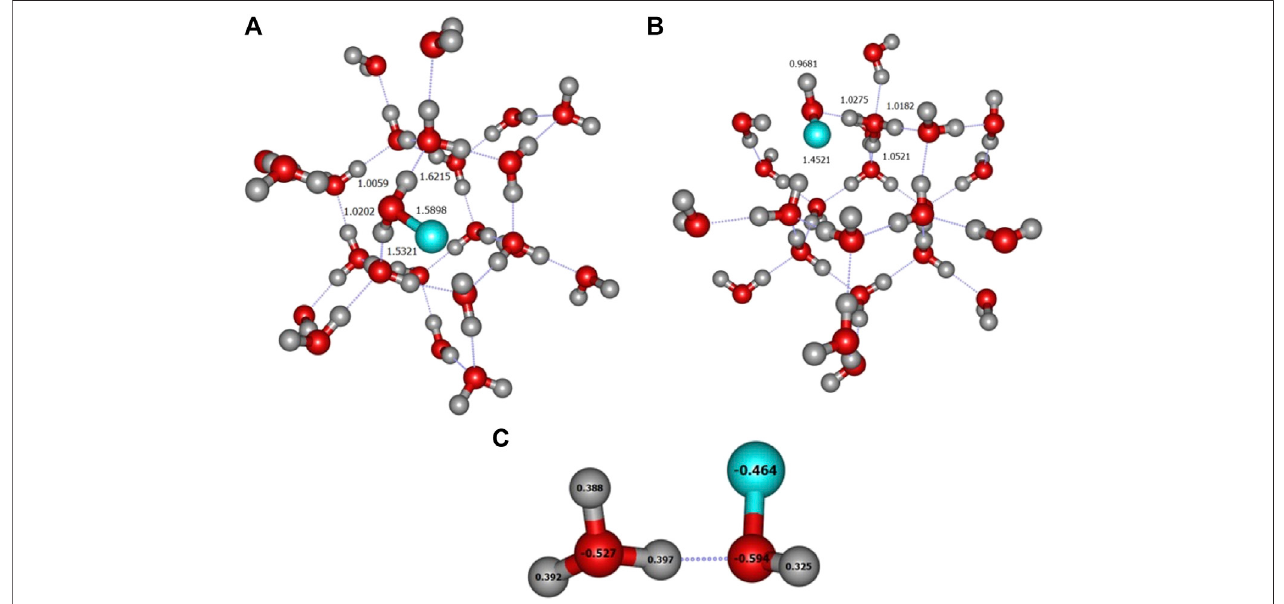
FIGURE 3 | (A) ONIOM( ω B97X-D/6-31+G**:PM6) most stable geometry (A2 site) for carbon atom. (B) Formation of the H 3 O + COH − complex (A4 site) (C) NBO charges of the H 3 O + COH − complex. These geometries were obtained on crystalline ice.